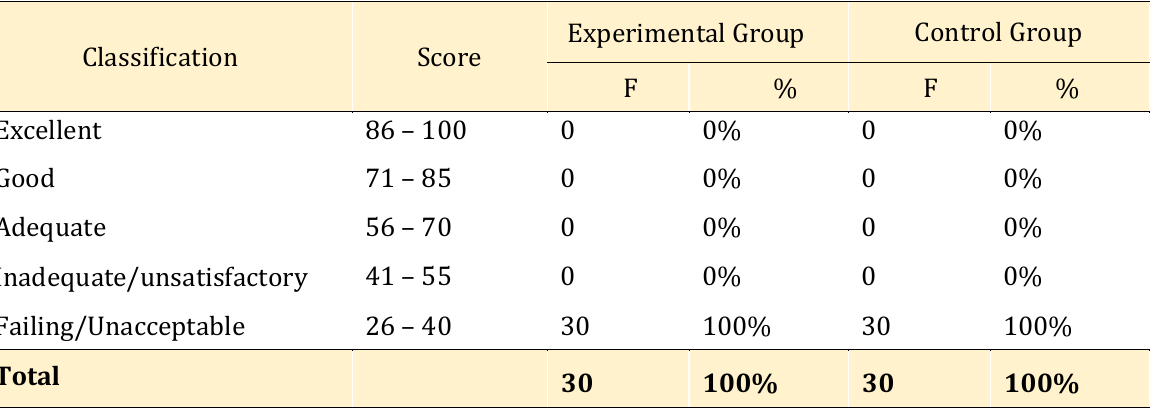
Table 7. The Rate Percentage and Frequency of Students’ Pretest Scores in Experimental